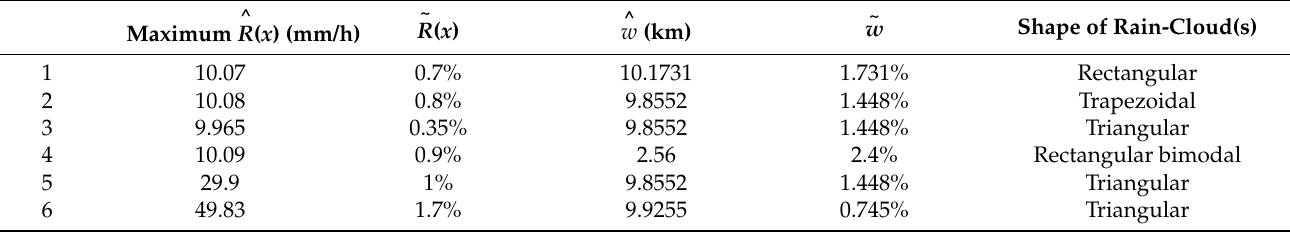
Table 3. Simulation result of the 6